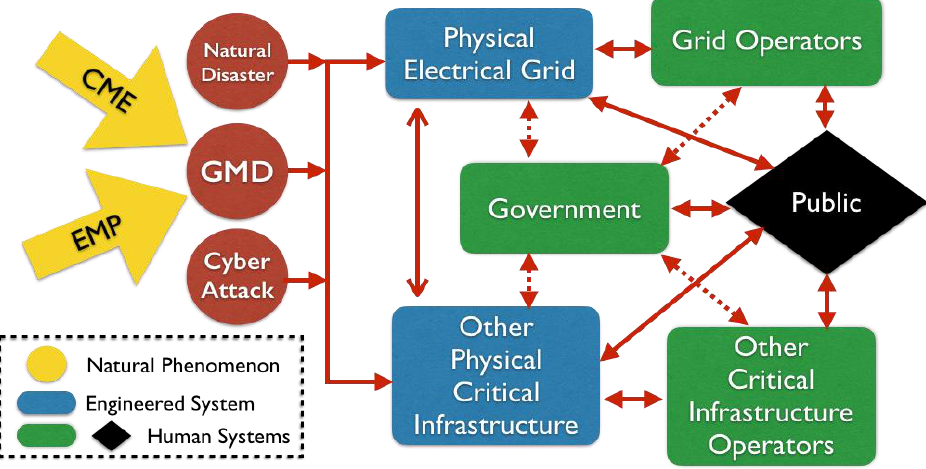
Figure 2. The Black Sky System (Source: S. R. Greene, Advanced Technology Insights,